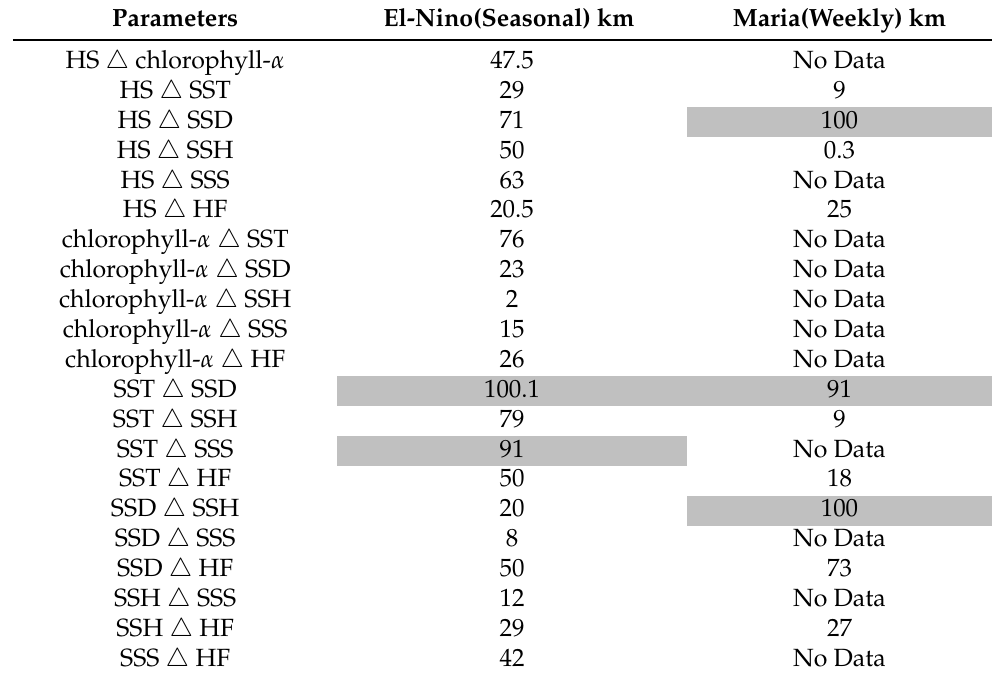
Table 2. Comparison of deviation between the KC centerline from weekly and seasonal mean. The highlights in grey represents the parameters with maximum